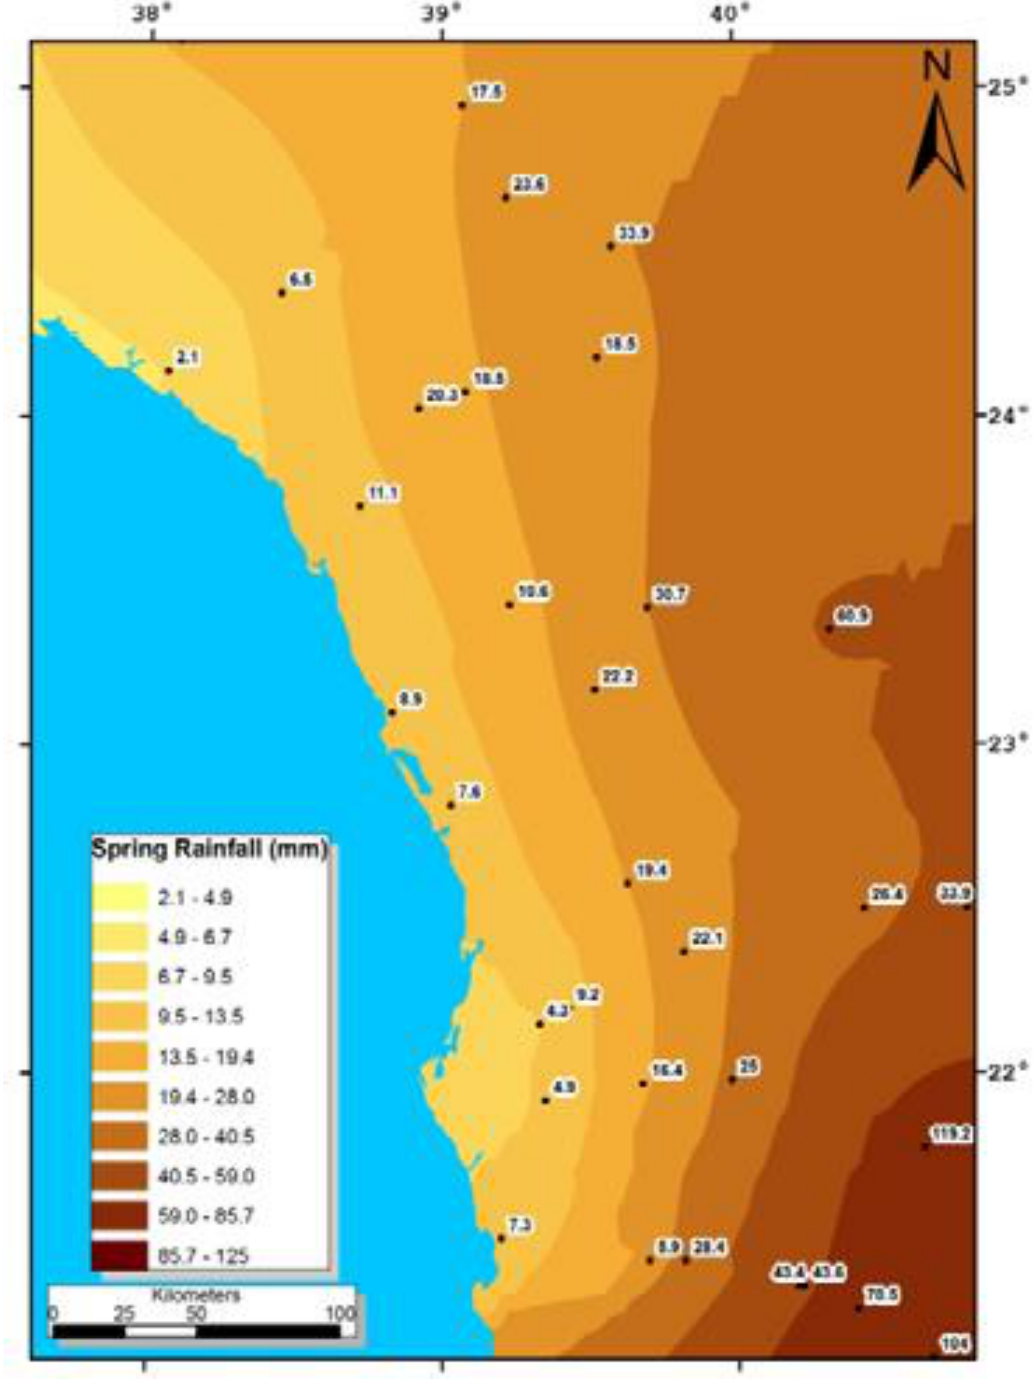
Figure 11. Isohyetal map for spring rainfall